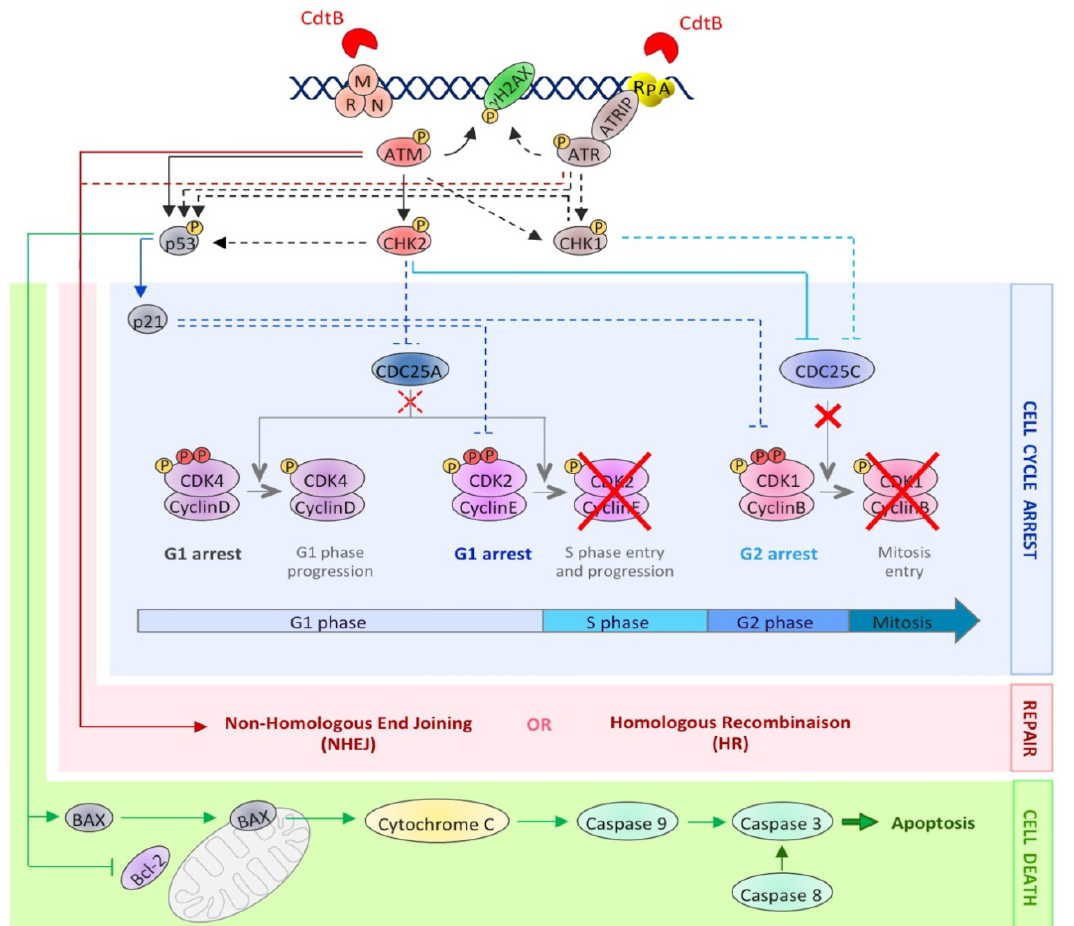
Figure 3. The activation of the DNA damage response upon CDT exposure. This picture depicts the DDR molecular events induced after CDT intoxication. The dotted lines represent well-studied events occurring during the DDR, but not yet demonstrated in the context of CDT exposure. CdtB-induced DNA lesions are detected by sensors, such as the MRN complex and RPA, resulting in the recruitment and the activation of the PI3K related kinases, ATM and ATR. ATM and ATR then phosphorylate hundreds of substrates, including H2AX, CHK1, CHK2 and p53 (black arrows). This signaling cascade results in the regulation of cell cycle modulators (blue lines), through the inhibition of CDC25C phosphatase by CHK2 and, possibly, CHK1. Phosphorylated CDC25C is unable to activate the cyclin B/CDK1 complex (red crosses), essential for mitotic entry. Moreover, the p53-dependent accumulation of p21 blocks cells in G1 by inhibiting the CDK2/cyclin E complex. At the same time, the DSB repair mechanisms (NHEJ and HR) are activated by ATM and ATR (red arrows). However, if the level of DNA lesions is too severe, the process of cell death is initiated (green arrows). Apoptotic cell death can be induced by an intrinsic pathway involving p53 activation, leading to an increase in the BAX level, the sequestration and inactivation of Bcl-2, the mitochondrial release of cytochrome C and caspase 9 activation. Apoptosis can also be induced through the activation of the extrinsic pathway, involving caspase 8 activation. In both cases, this leads to caspase 3 activation and apoptotic cell